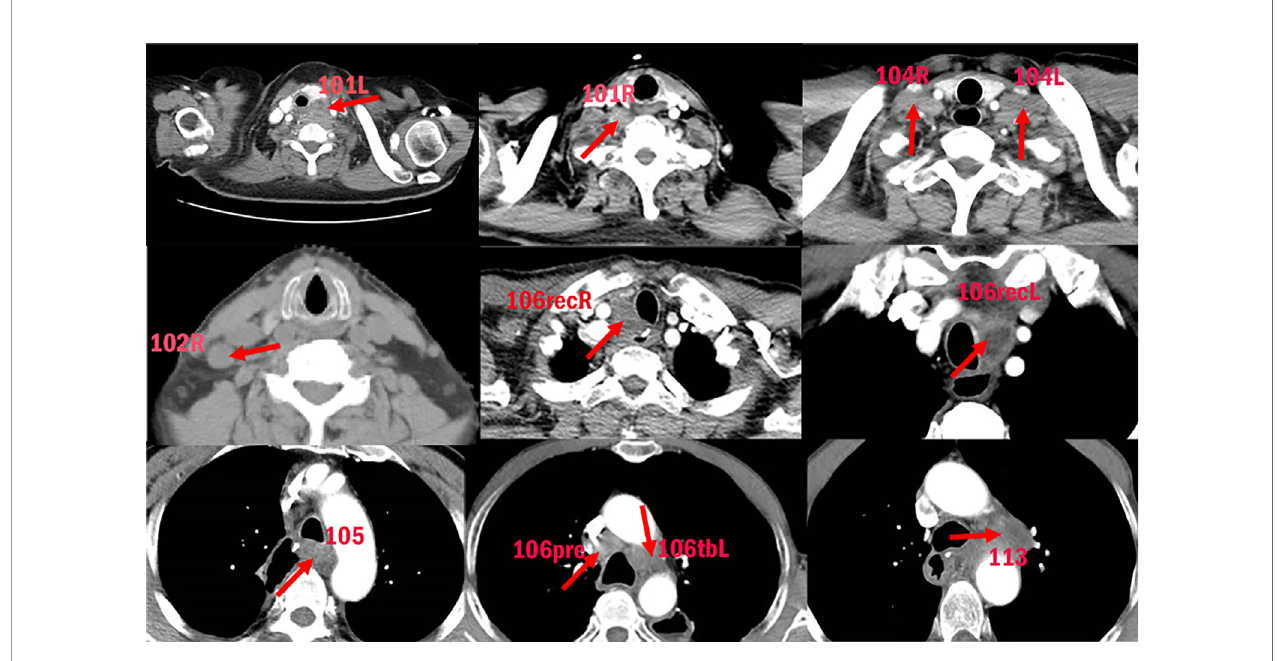
FIGURE 1 | Examples of LNR in different stations.